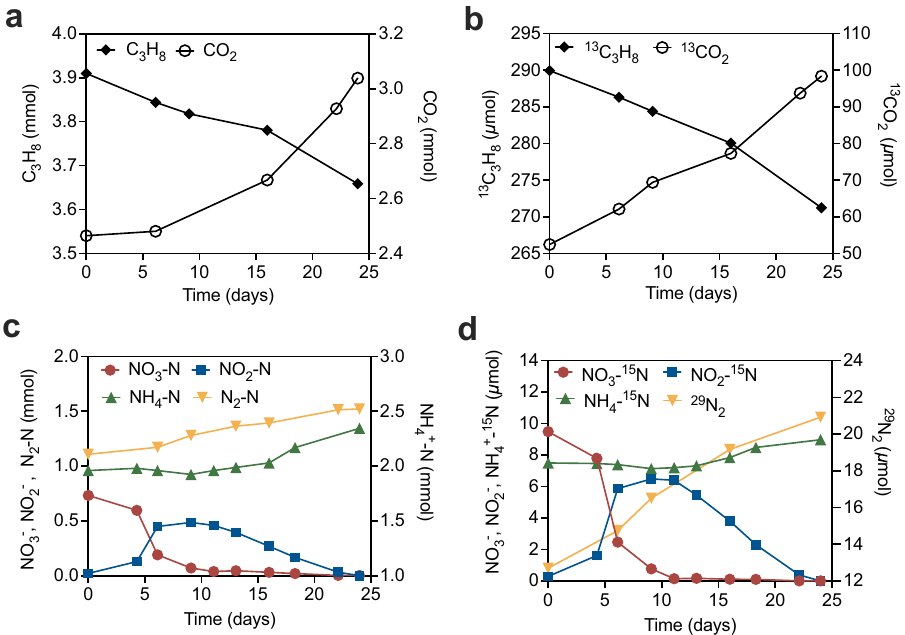
Fig. 1 | Anaerobic oxidation of propane coupled to nitrate reduction by the enrichment culture during the isotope labelling test. a Conversion of C 3 H 8 to CO 2 , b 13 C 3 H 8 to 13 CO 2 , c NO 3 − to NH 4 + and N 2 with transitory formation of NO 2 − ,